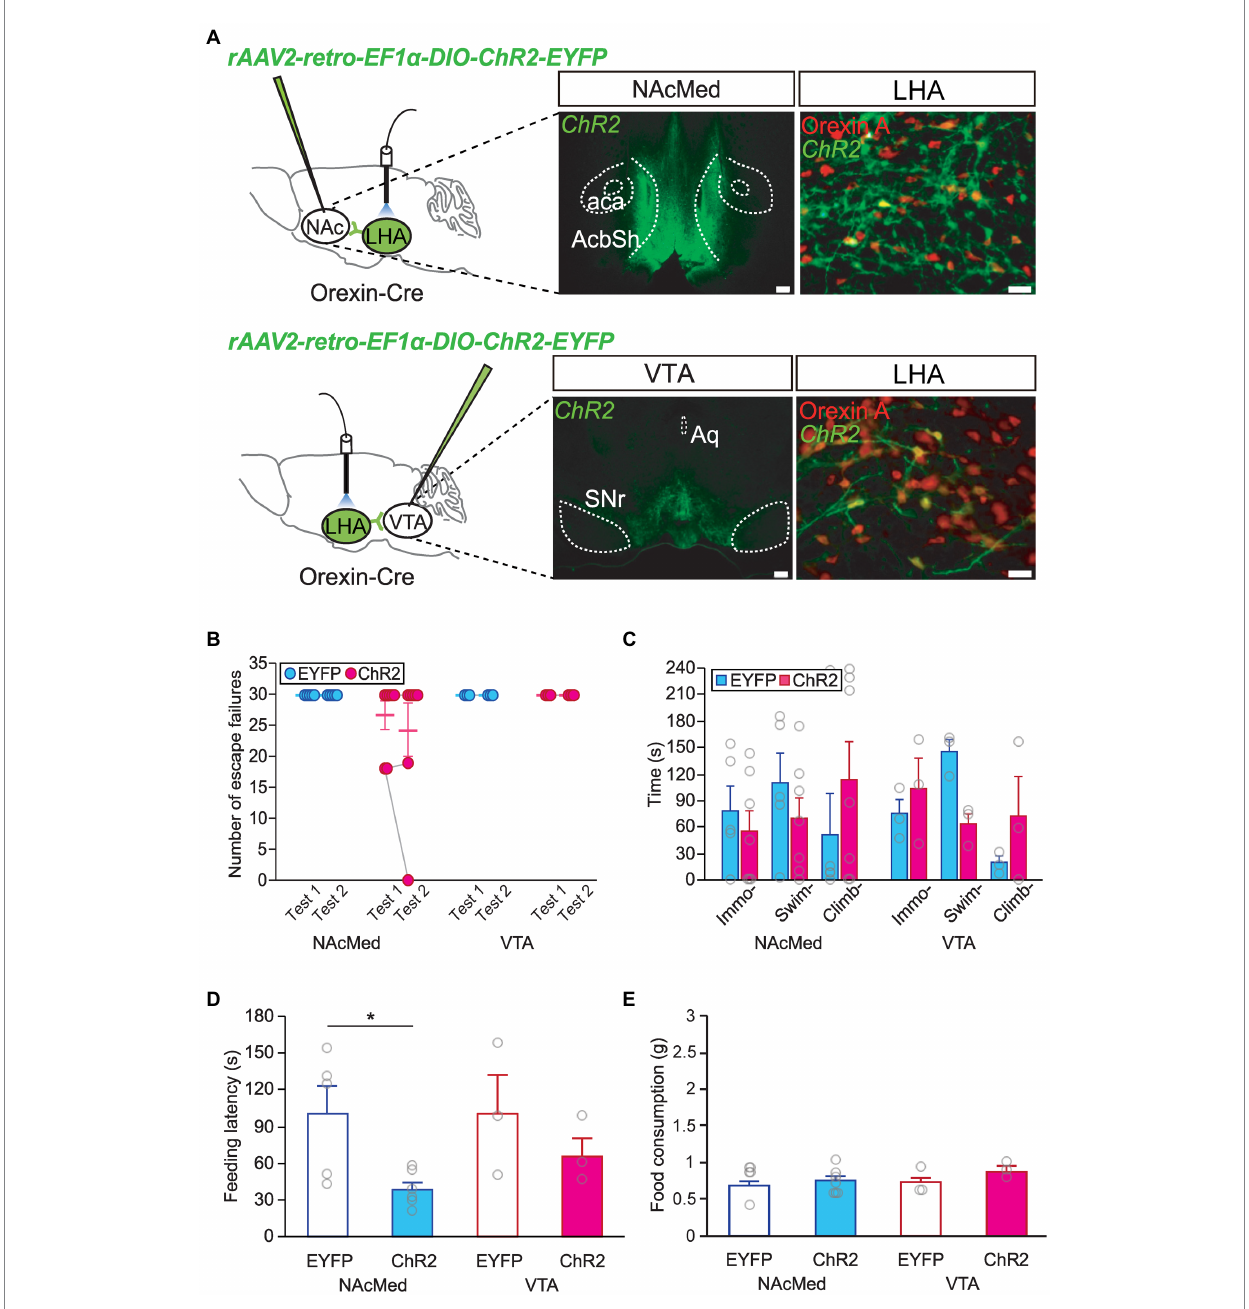
FIGURE 4 Orexinergic inputs to the NAcMed mediate food-seeking behavior in the novelty suppressed feeding (NSF) test. (A) Representative images and diagrams of the sites of virus injection [NAcMed or ventral tegmental area (VTA), scale bar indicates 200 μ m] and optical stimulation [lateral hypothalamic area (LHA), scale bar indicates 20 μ m]. AcbSh, nucleus accumbens shell; aca, anterior commissure; Aq, aqueduct; SNr, substantia nigra pars reticulata. (B) Optogenetic activation of orexinergic neurons projecting to the NAcMed or the VTA failed to induce a significant change in stress resilience in the learned helplessness test (LHT) (NAcMed, EYFP n = 5, ChR2 n = 7; VTA, EYFP n = 3, ChR2 n = 3). (C) Optogenetic activation of orexinergic neurons projecting to the NAcMed or the VTA failed to induce a significant behavioral change in the FST. (D) Activating orexinergic neurons